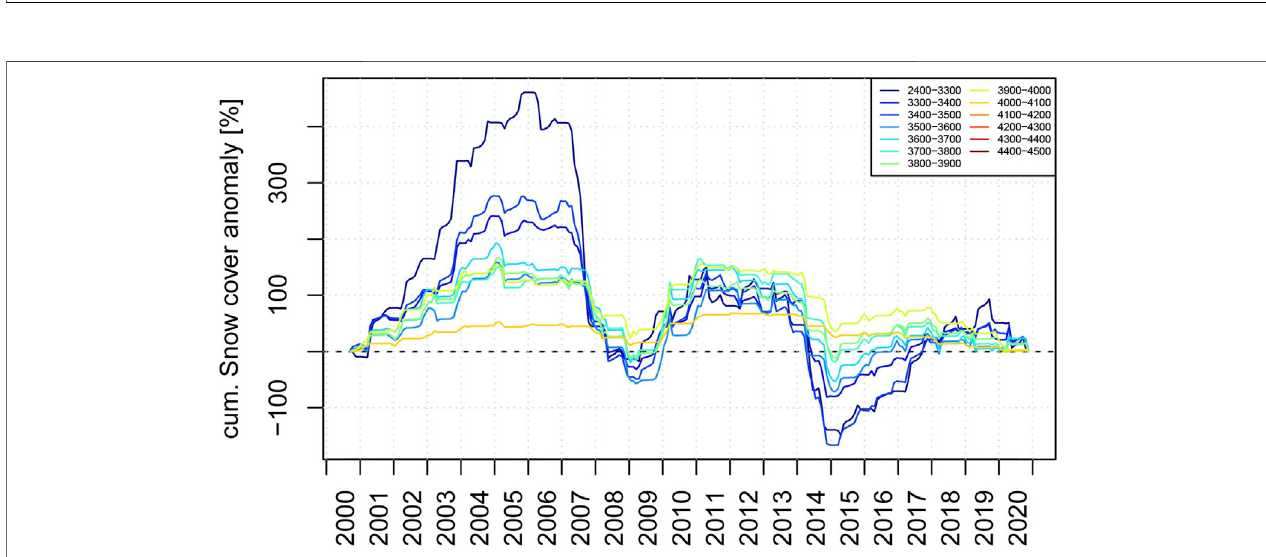
FIGURE 10 | Same as Figure 9 but for the Small Naryn catchment. Weaker positive anomalies in 2009 and 2010 compared to the Big Naryn catchment are